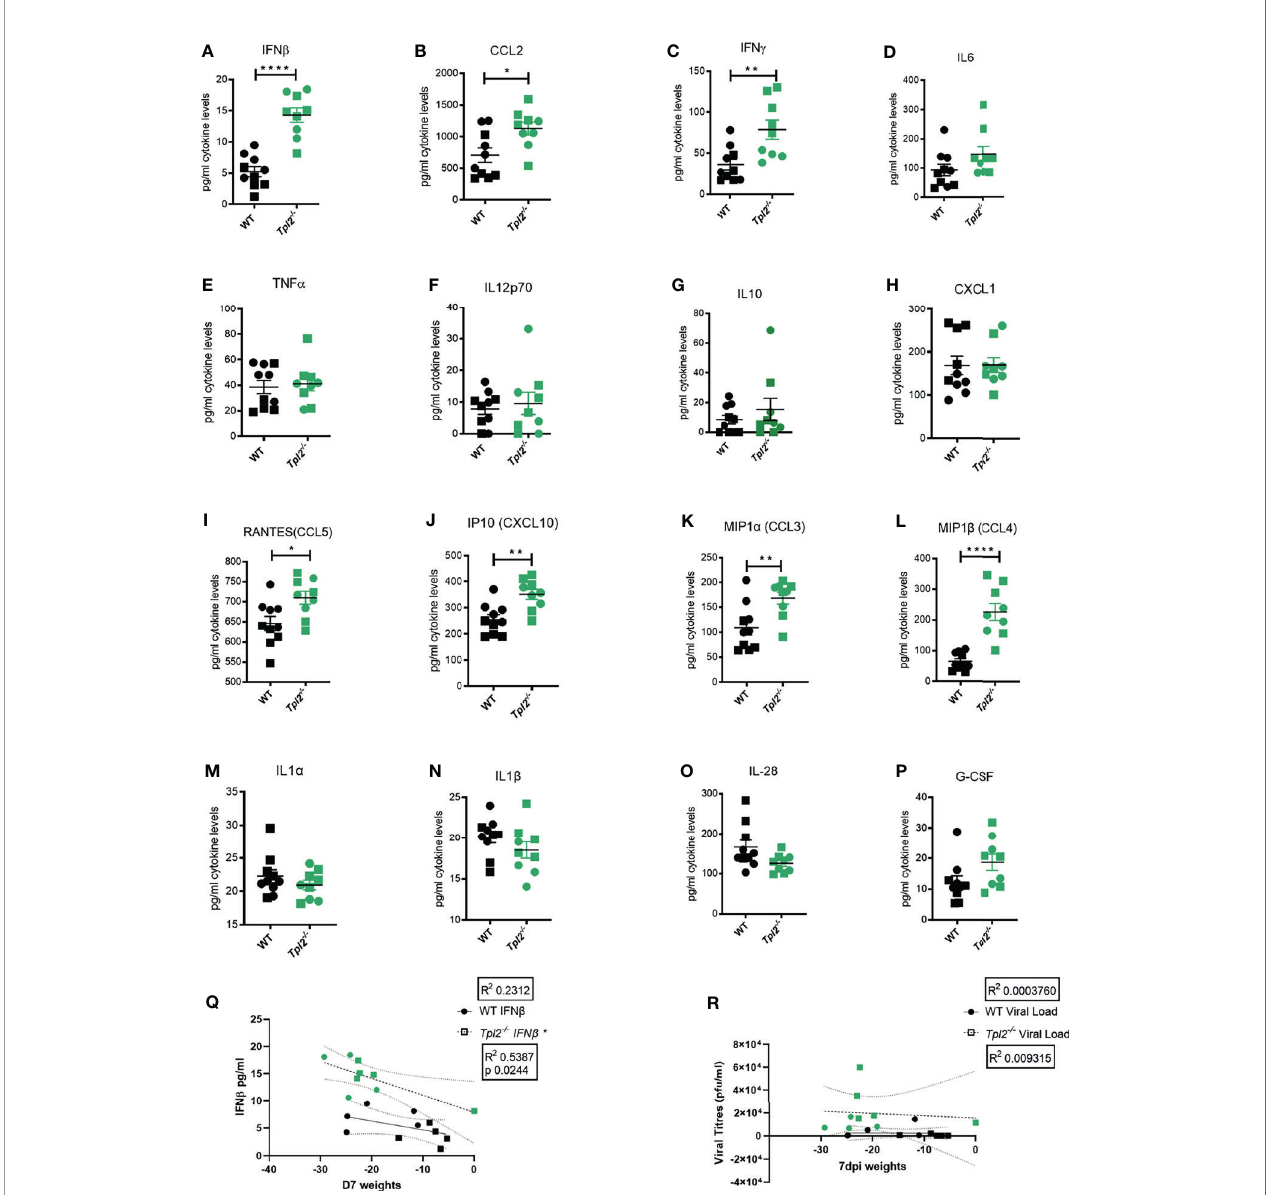
FIGURE 2 | Excessive IFN cytokine signature is observed in in fl uenza-infected Tpl2 -/- mice at 7 dpi. WT (n = 10) and Tpl2 -/- (n = 9) mice were infected intranasally with 10 4 pfu of in fl uenza x31 and euthanized at 7 dpi. (A – P) The lungs were homogenized for analysis of cytokine expression. Squares represent male mice, and circles represent female mice. Data are representative of 2 experiments. Unpaired student ’ s t -test *p<0.05, **p<0.01, ****p<0.0001. (Q) Correlation of Interferon levels in the perfused and lavaged lungs with weight loss at 7 dpi. (R) Correlation of viral titers in the perfused and lavaged lungs with weight loss at 7 dpi. Data are representative of 2 experiments. Two tailed Pearson ’ s Correlation test was performed